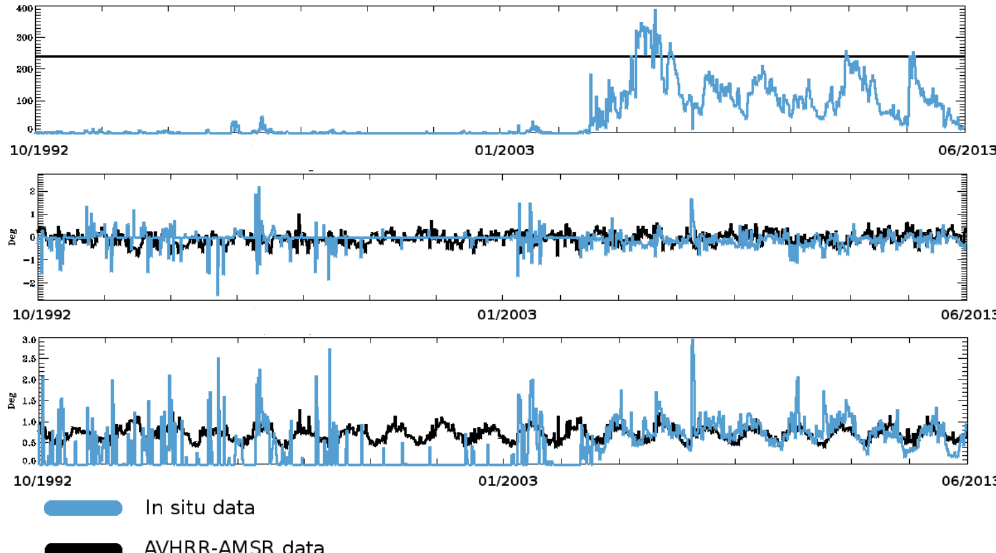
Figure 4. Time series of weekly sea surface temperature (SST; ◦ C) data assimilation statistics from in situ (blue) and satellite SST AVHRR- AMSR (black), averaged over the whole Mediterranean basin : number of data (top), mean innovation (middle) and rms of innovation